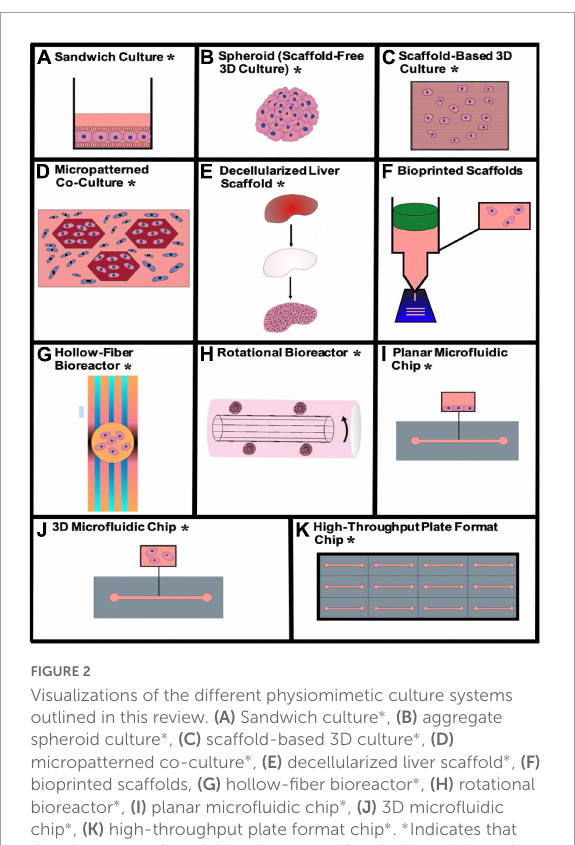
FIGURE2 Visualizations of the different physiomimetic culture systems outlined in this review. (A) Sandwich culture ∗ , (B) aggregate spheroid culture ∗ , (C) scaffold-based 3D culture ∗ , (D) micropatterned co-culture ∗ , (E) decellularized liver scaffold ∗ , (F) bioprinted scaffolds, (G) hollow-fiber bioreactor ∗ , (H) rotational bioreactor ∗ , (I) planar microfluidic chip ∗ , (J) 3D microfluidic chip ∗ , (K) high-throughput plate format chip ∗ . ∗ Indicates